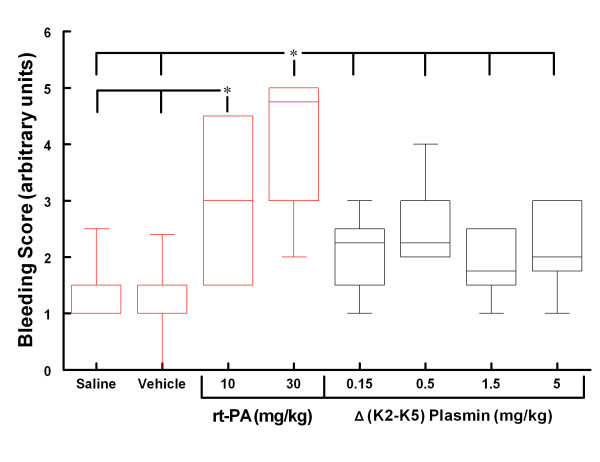
General behavioral score. * p < 0.05 compared to all other groups; † p < 0.05 compared to vehicle; ‡p < 0.05 compared to saline (Kruskal-Wallis, Newman-Keuls; n = 6, 6, 5, 6, 6, 6, 6, 5, respectively). Values are the median ± the 5 and 95 percentile.